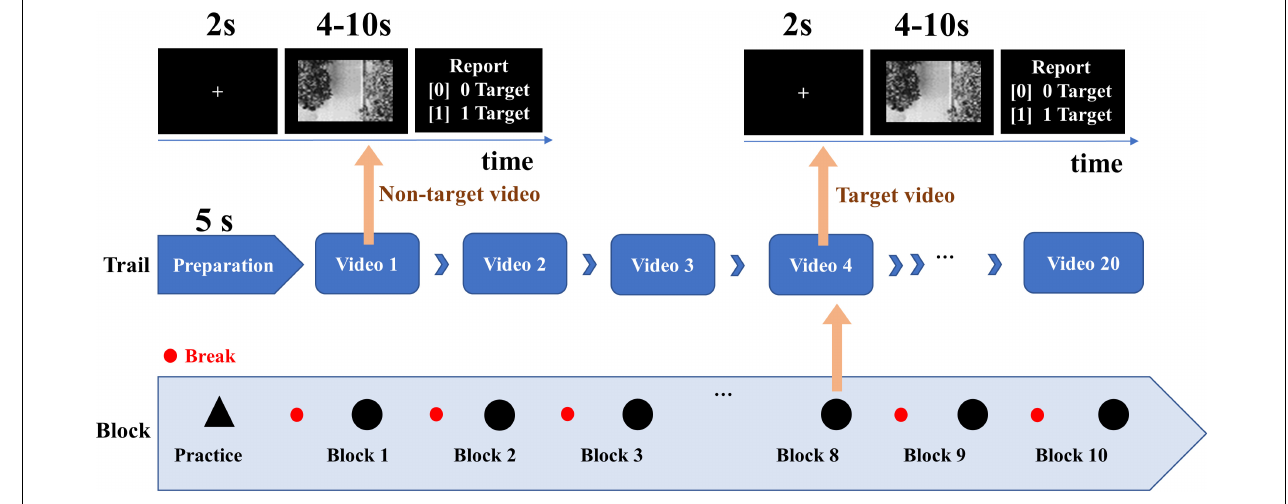
FIGURE 1 | Experimental paradigm of UAV video target detection (Song et al., 2021a).